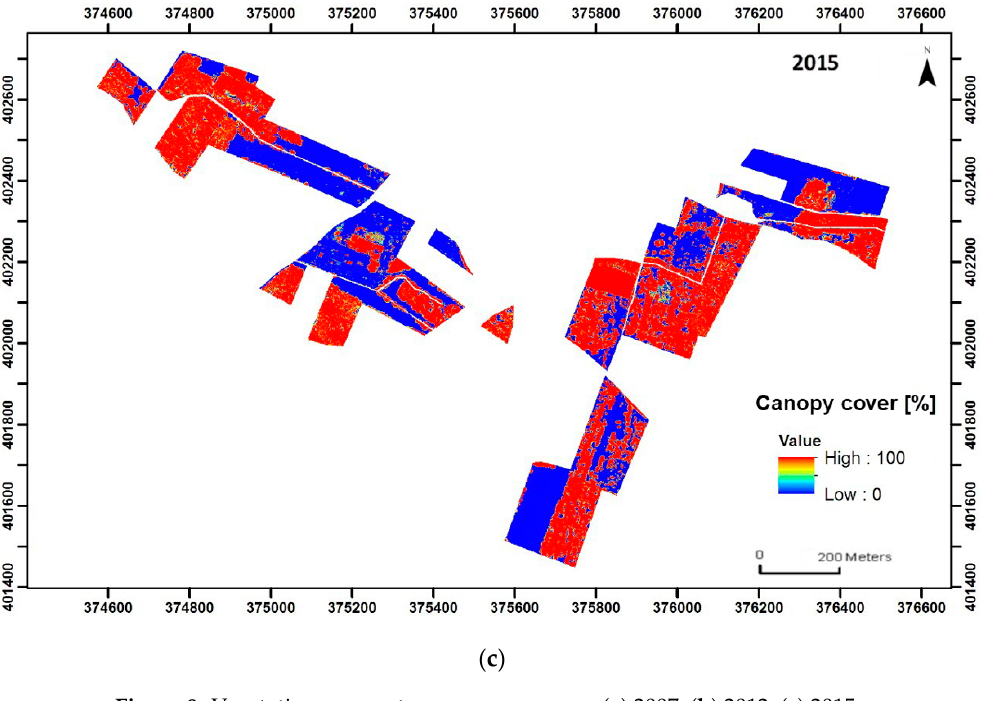
Figure 8. Vegetation parameters—canopy cover: ( a ) 2007; ( b ) 2012; ( c ) 2015.